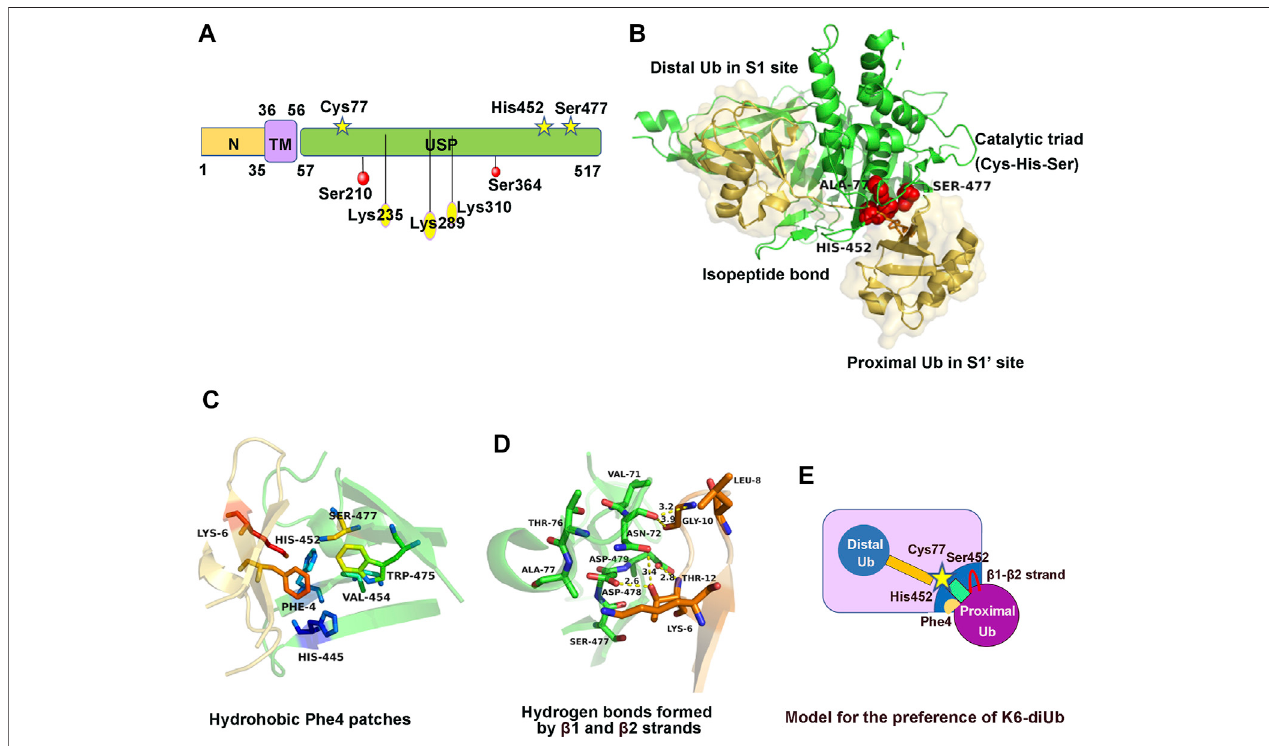
FIGURE 1 | Structure, regulation, and molecular characteristics of USP30. (A) Domain structure and post-translational modi fi cation sites of USP30. (B) Crystal structure of USP30 complexed with K6-di-Ub. Ubiquitin molecules are shown with a transparent surface in light yellow. The catalytic triad is shown in red. (C) The ubiquitin Phe4 patches contacting a hydrophobic surface of USP30 near its catalytic triad. (D) Coordination of β 1 – β 2 strands and USP30 thumb and palm domains to form hydrogen bonds. (E) Cartoon model to illustrate the preference of USP30 for the cleavage of